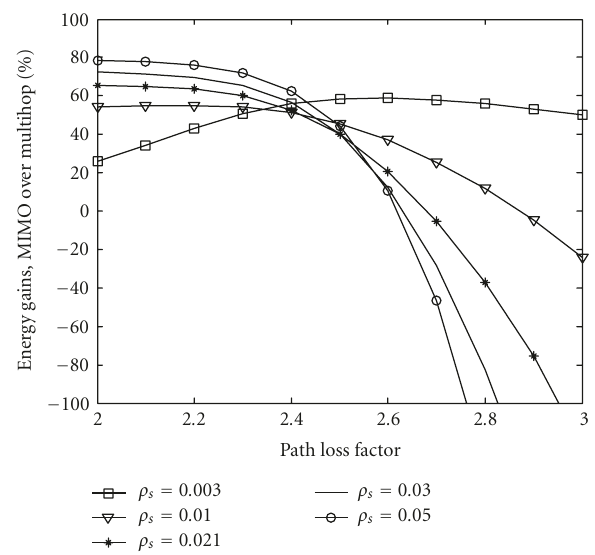
Figure 7: Total energy consumption versus density when n = 2 and D = 40, D = 100.